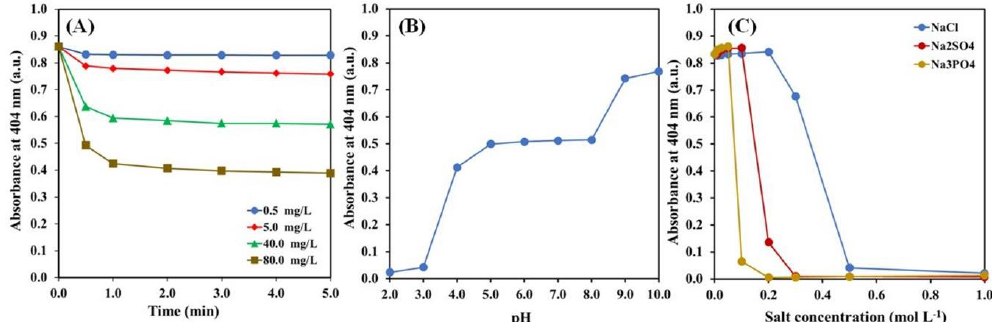
Figure 6. Effect of different parameters on the detection of mercury (II) using the Au–Ag BNPs: ( A ) incubation time, ( B ) pH of the reaction media and ( C ) salt type (NaCl, Na 2 SO 4 and Na 3 PO 4 ) and salt concentration.